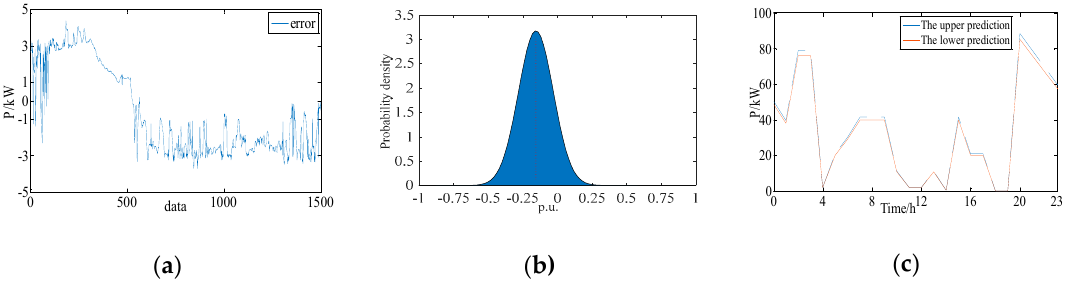
( c ) Figure 4. PV output per hour ( a ), WT output per hour ( b ), WT Prediction and actual output of 1500 data ( c ). Based on the probability density function, we can get the corresponding confidence interval ,